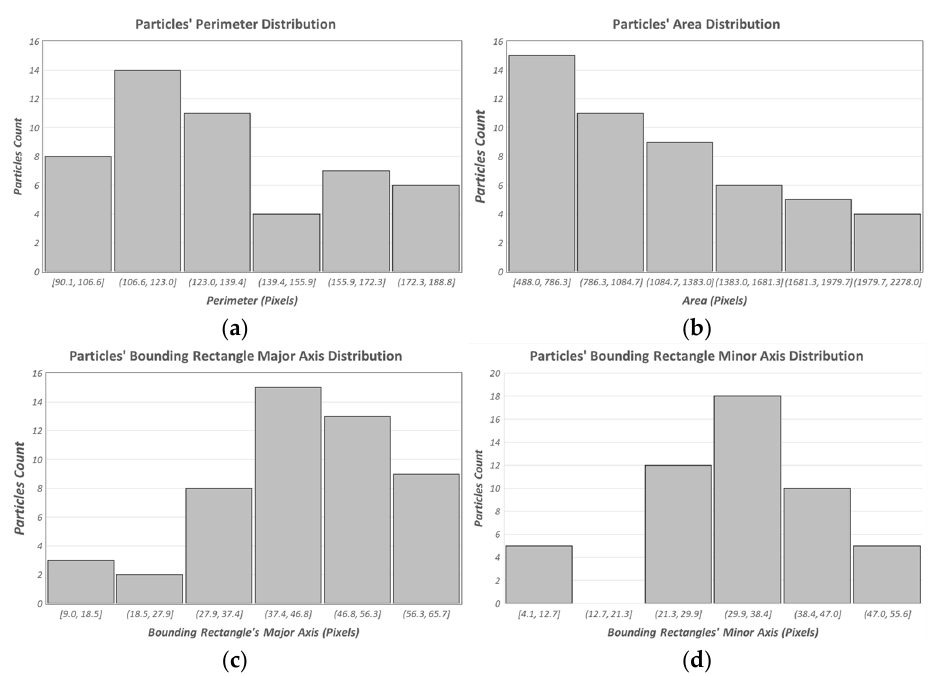
Figure 8. Distributions of core characteristics estimated for the case of particle samples shown in Figure 3a. ( a ) Perimeter, ( b ) area, ( c ) minor axis of the bounding rectangle, ( d ) major axis of the bounding rectangle.